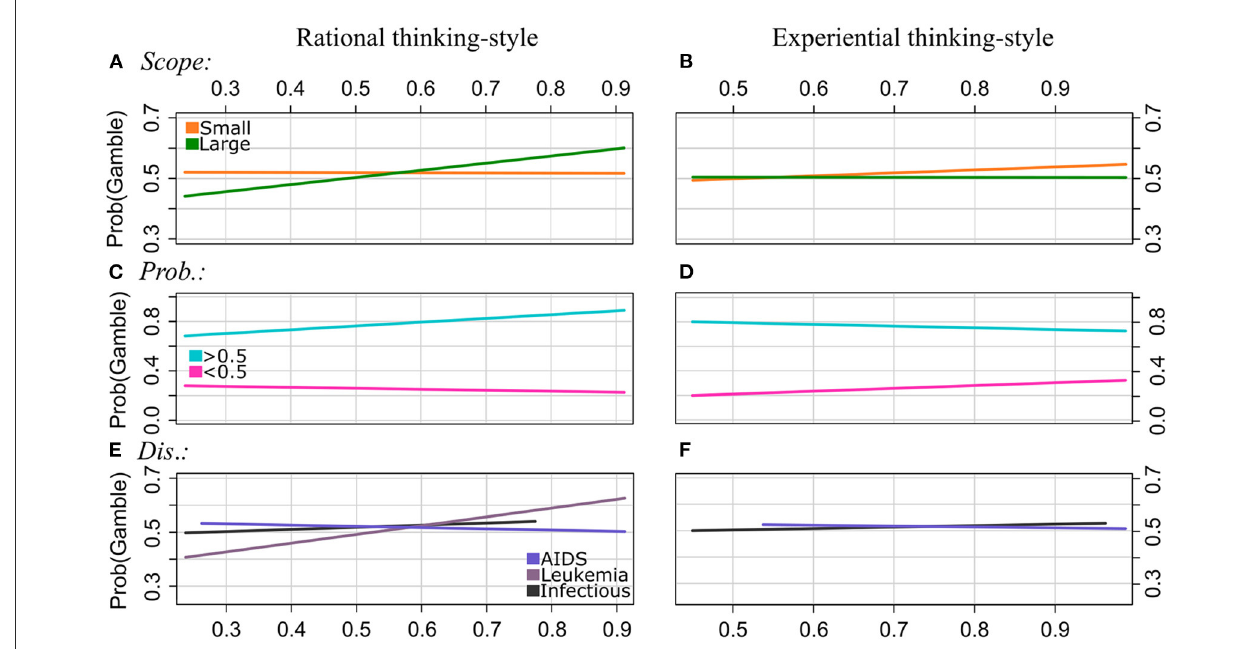
FIGURE1 Experiment 1: Regression lines of the proportions of choosing the gamble option as a function of rational thinking-style (left column) and experiential thinking-style (right column), separately for the levels of Scope [patterns (A, B) ], Probabilities (C, D) , and Disease (E, F) . Note that we applied a smaller range of values on the y-axis for the plots of the patterns (A, B, D, E) to illustrate the interaction effect more clearly.